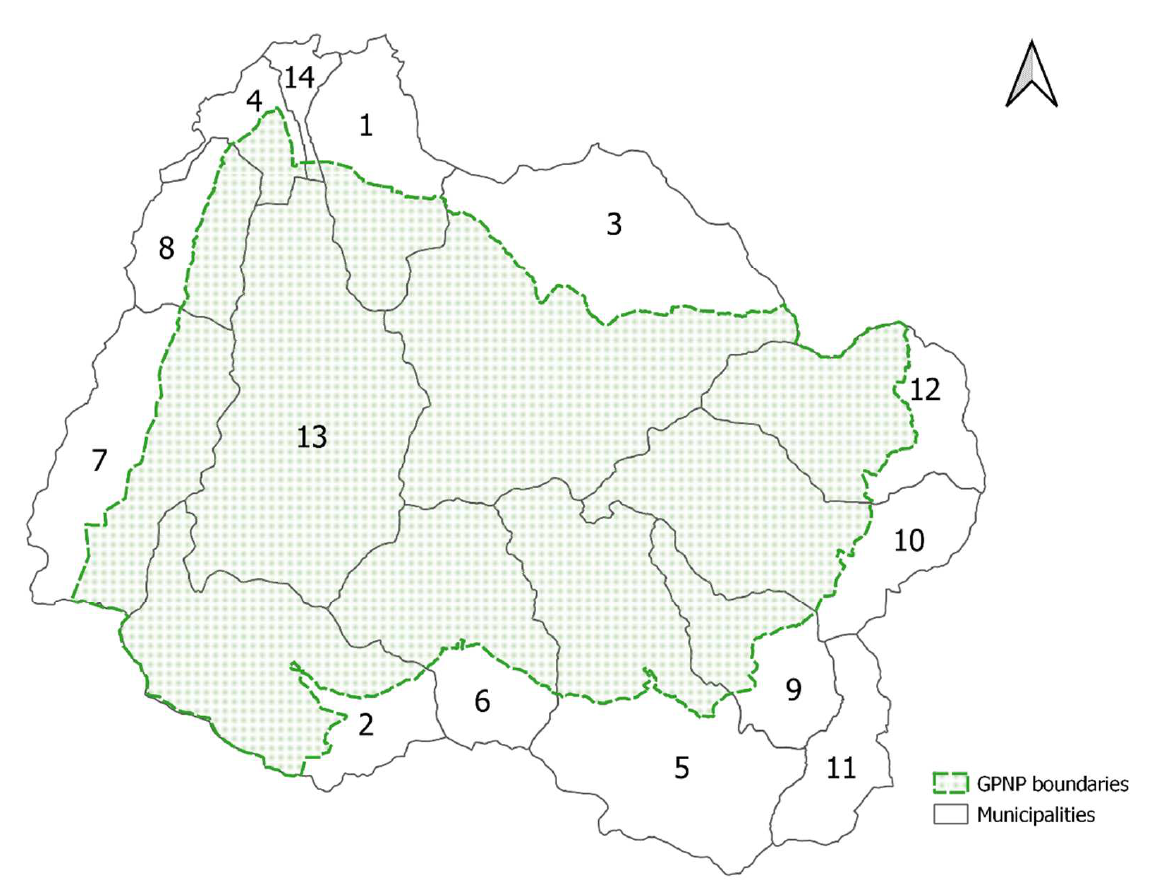
Figure 1. The study area in Gran Paradiso National Park (GPNP). The green dotted line shows the park boundaries that are under the jurisdiction of two regions. Piedmont region: Val Soana (villages: Valprato Soana 12 and Ronco Canavese 10); Valle Orco (villages: Ceresole Reale 2, Noasca, Locana 5, Sparone 11 and Ribordone (9). Aosta Valley region: Valle di Cogne (villages: Cogne 3 and Aymavilles 1); Valsavarenche (villages: Valsavarenche 13, Introd 4 and Villeneuve 14); Val di Rhêmes (villages: Rhêmes-Notre-Dame 7 and Rhêmes-Saint-Georges 8).